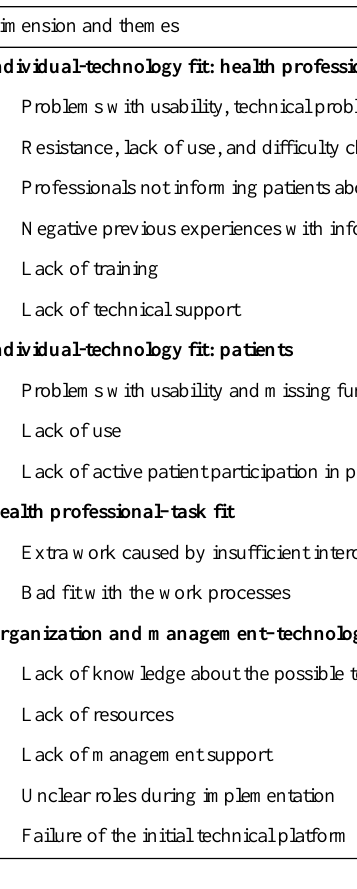
Table 3. Challenges of implementing eHealth services for